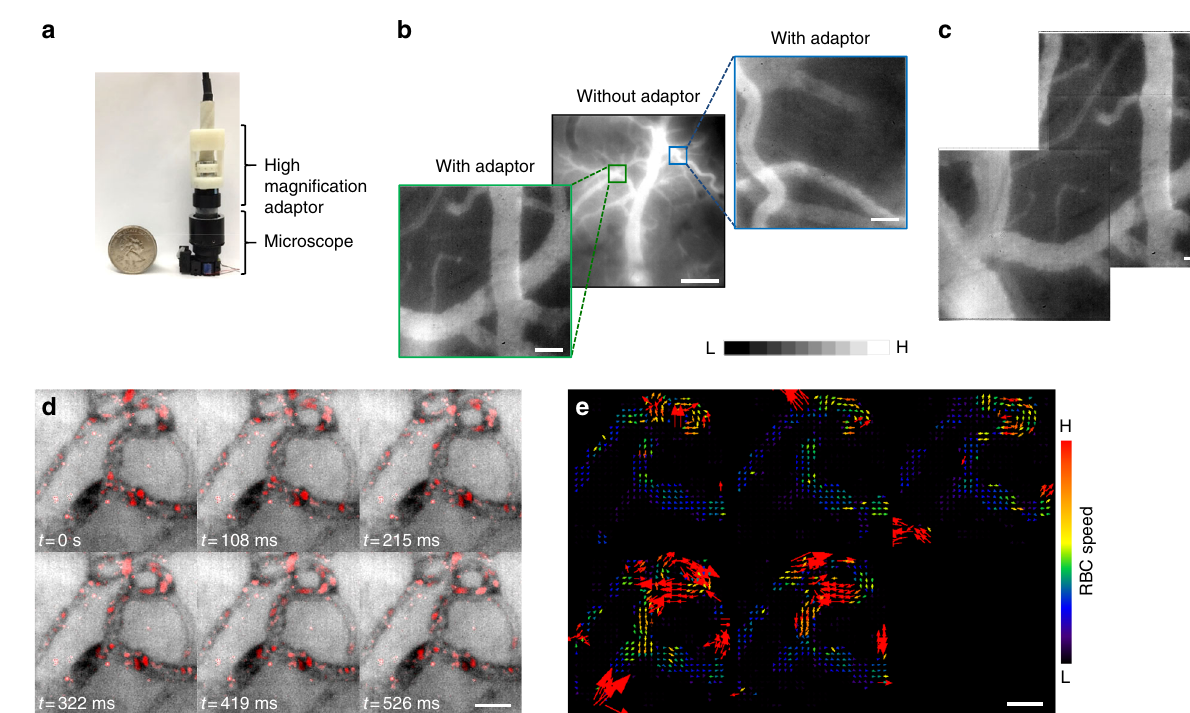
Fig. 7 3D printed high-magni fi cation adapter reveals microvascular hemodynamics. a The microscope is shown with the 3D printed high-magni fi cation adaptor alongside a U.S. quarter coin for scale. b Image of fl uorescent dye enhanced cortical vasculature ROI. Insets are magni fi ed fi elds of view from this ROI. c High-magni fi cation mosaic stitched together from three different fi elds of view. Images in b , c are normalized to 1% of their intensity ranges. d Video frames from a fl uorescent-dye enhanced vessel plexus from the mouse ear in which the RBCs have been highlighted in red. One can clearly visualize the motion of individual RBCs over time in each vessel segment, from which one can conduct particle velocimetry and compute the direction and magnitude of RBC fl ux as shown in e . Cortical and ear microvascular data presented are from two different animals, respectively. Scale bar indicates 50 μ m, except in b : where it is 500 μ m. Arrows indicate vessel sprouting during D6-D11. Also see Supplementary Movie